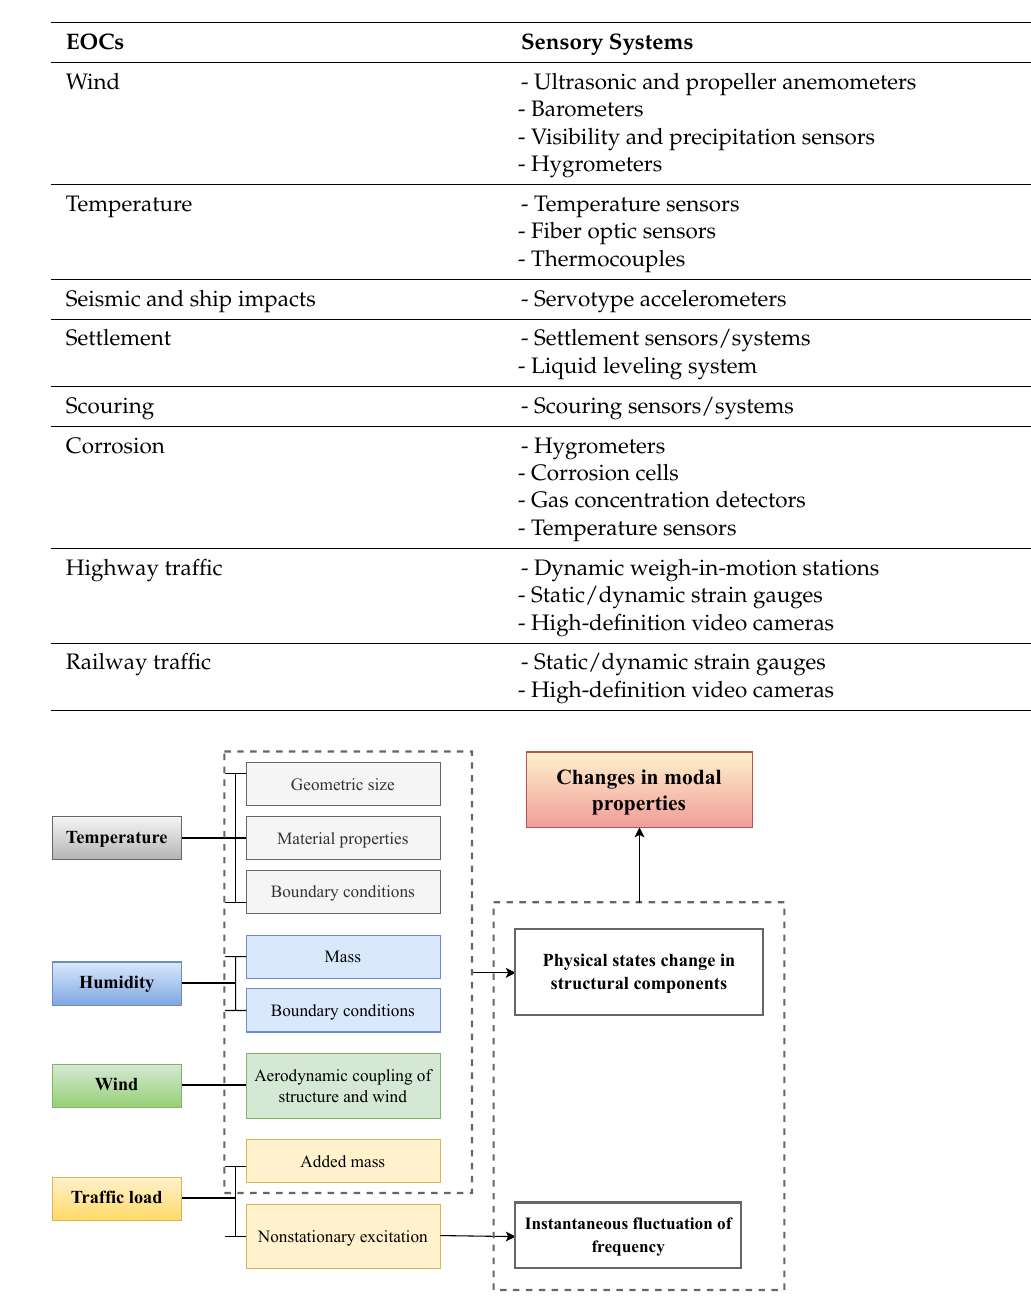
Table 15. Typical EOCs and suitable sensors for SHM systems.